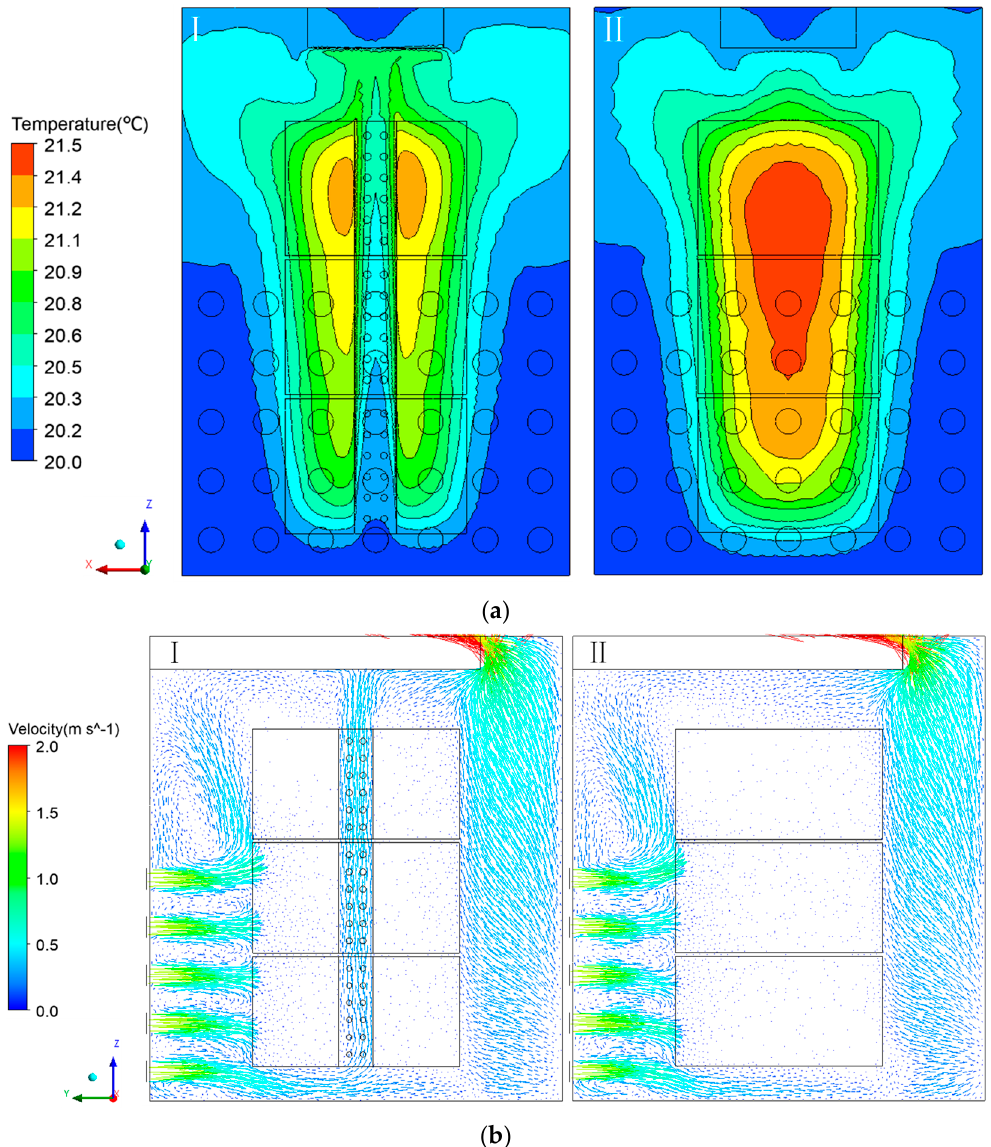
Figure 16. The distribution of the stacking plastic baskets with a ventilation duct and non-ventilation duct (at 10 h of cooling): ( a ) Temperature distribution of the fresh tea leaves (I. plastic basket with a ventilation duct; and II. plastic basket without a ventilation duct). ( b ) Airflow distribution of the fresh tea leaves (I. plastic basket with a ventilation duct; II. plastic basket without a ventilation duct).